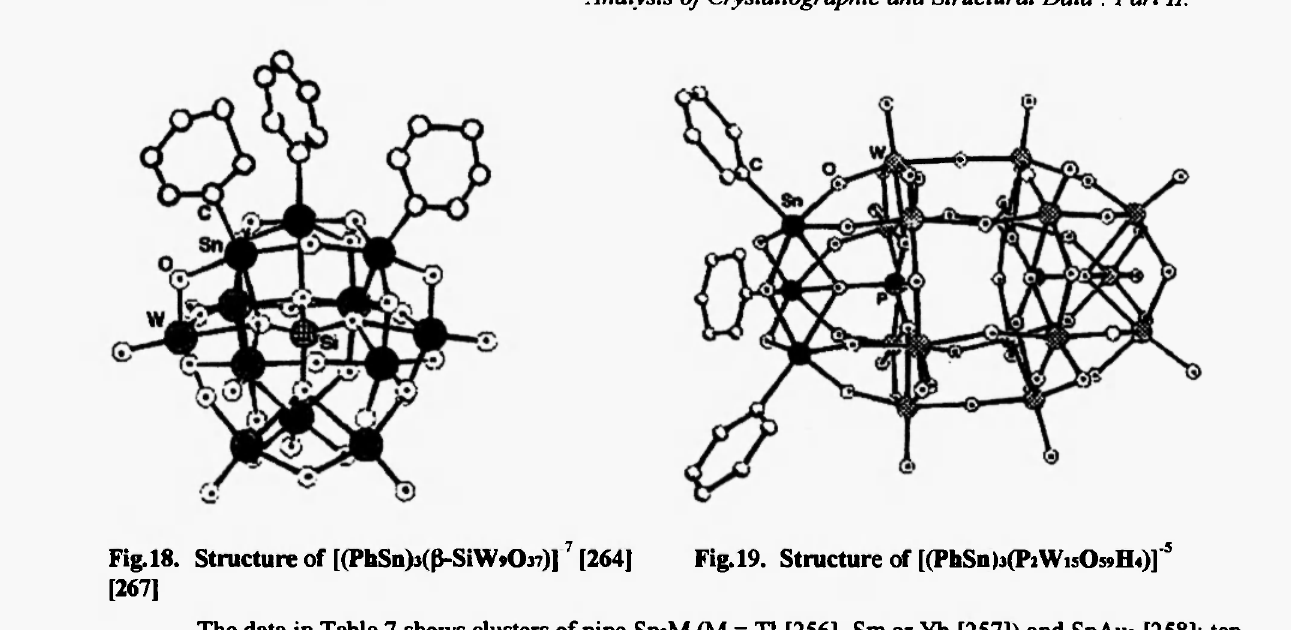
Fig. 18. Structure of [(PhSn)i(ß-SiW»Oj7)1 7 [264J Fig. 19. Structure of [(PhSnbflPiWuOssH^]